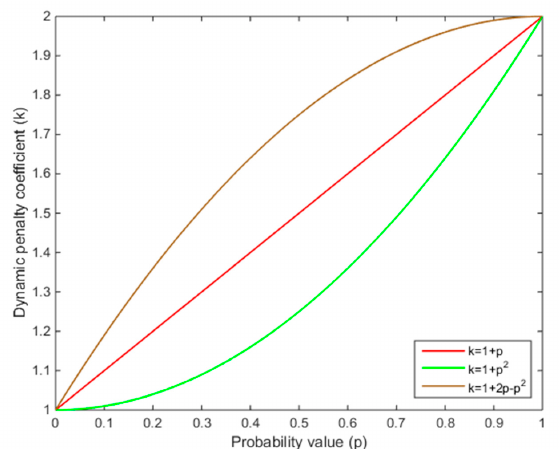
Figure 3. Relationship between the probability of committing traffic violations and the dynamic penalty coefficient.